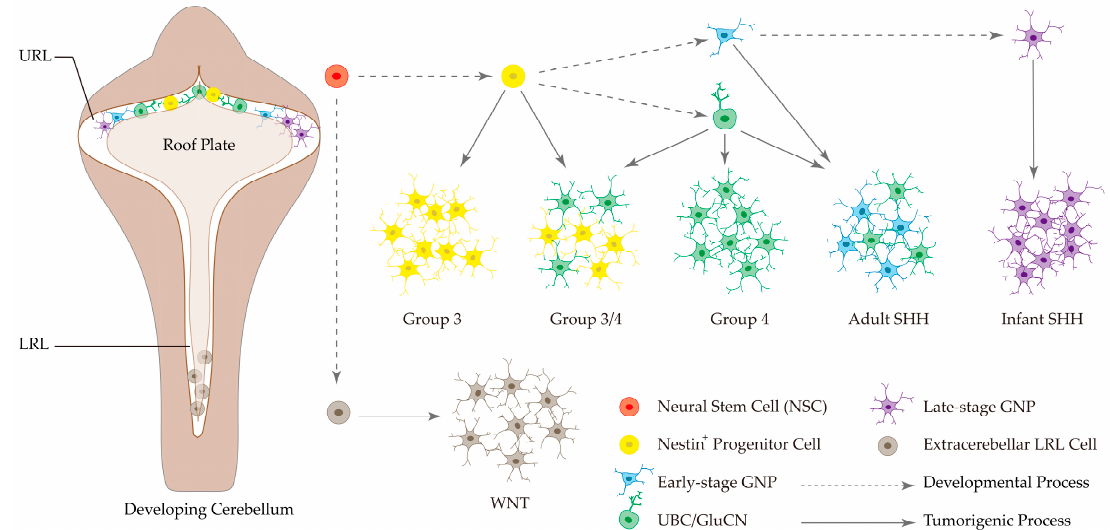
Figure 3. Distinct subtypes of MB originate from different progenitor cells and developmental stages. The dotted arrow represents developmental process, while the solid arrow represents tumorigenic process. Cells with same color have the same origination. This figure was made based on data from the references [17,18].